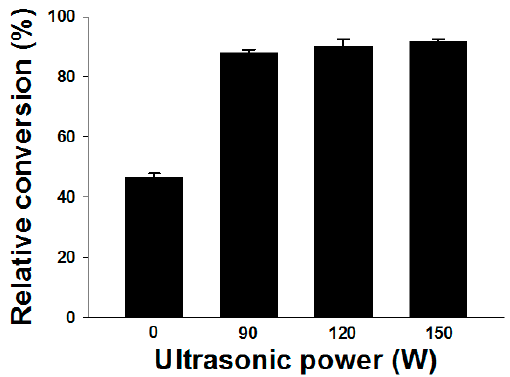
Figure 2. Effects of ultrasonic treatment on the lipase-catalyzed synthesis of retinyl laurate. The lipase- catalyzed synthesis of retinyl laurate was conducted under traditional shaking of 100 rpm (ultrasonic power of 0 W) or indicated intensities of ultrasonic treatment (90–150